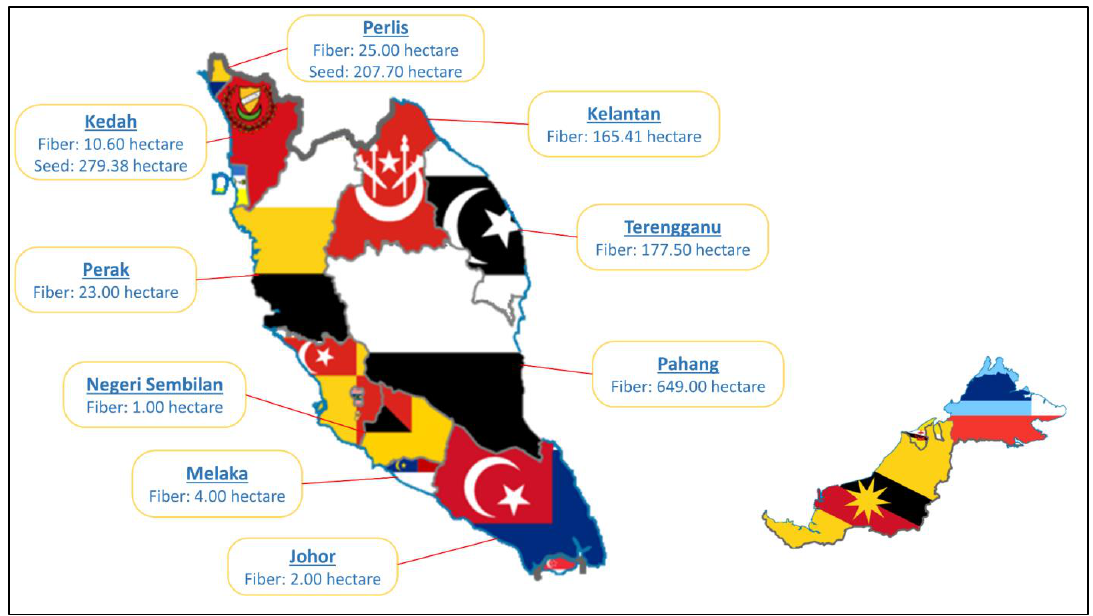
Figure 3. Kenaf and seed hectarage according to state